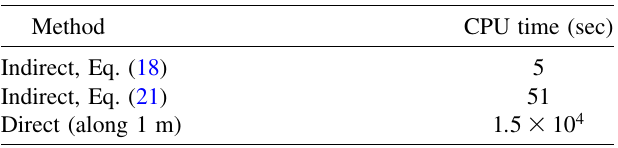
FIG. 8. Wake potential of rectangular collimator calculated with direct and indirect (Sec. III D) methods. TABLE I. Comparison of CPU times for the example of the rectangular collimator.